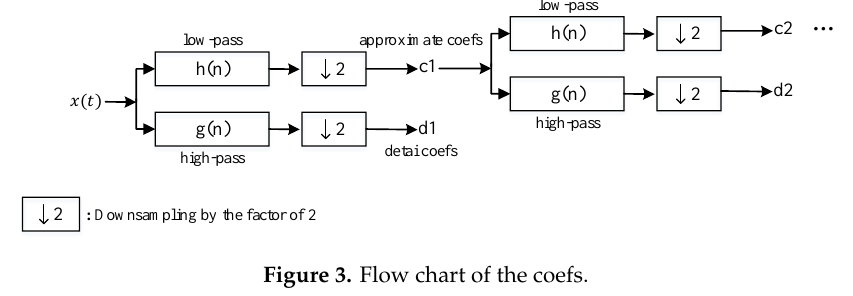
Figure 3. Flow chart of the coefs.